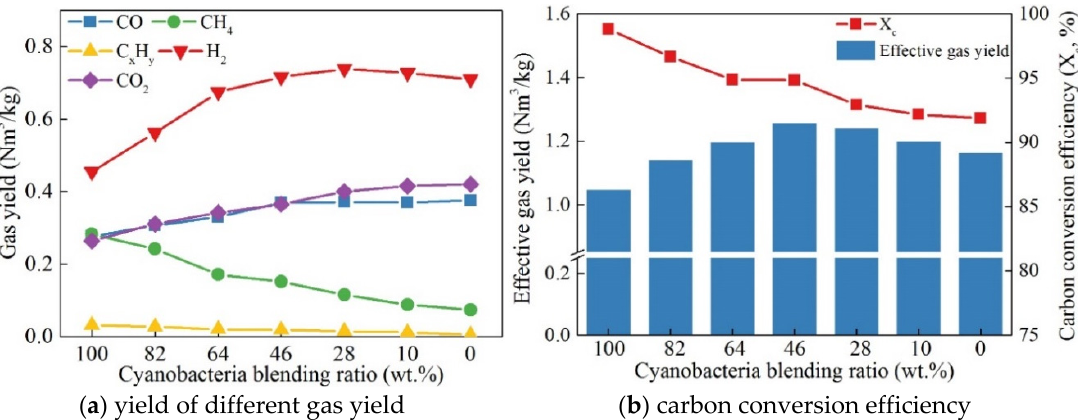
Figure 7. The gas yield and carbon conversion efficiency as a function of the cyanobacterial blending ratio under 900 ° C and a 0.3 oxygen carrier-to-fuel ratio.